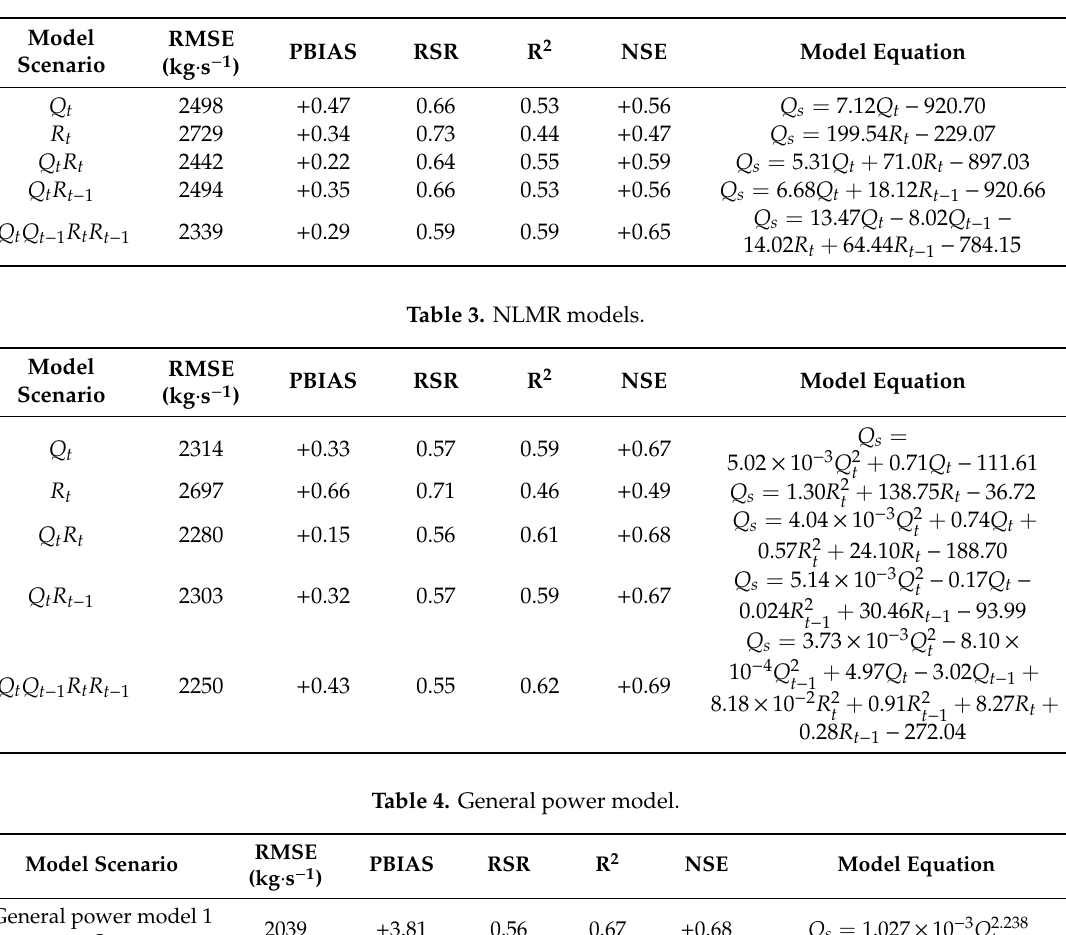
Figure 11. ( a ) Seasonal suspended yield from the catchment. Central lines indicate the median, bottom and top edges of the box indicate the 25th and 75th percentiles respectively. The whiskers extend to the most extreme data points not considered outliers, the ‘ + ’ symbol represents outliers (1.5 fold interquartile range), the circle shows the mean value. ( b ) Yearly suspended sediment transport and hysteresis index (HI mid ). Table 2. MLR models.